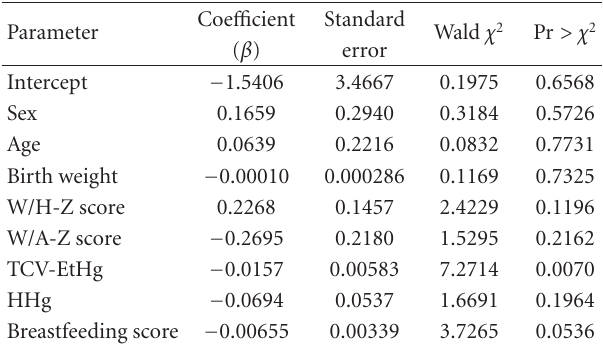
Table 2: Results of the logistic regression of a child showing a score above the median; a negative sign demonstrates a diminished